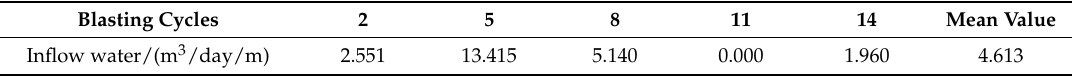
Table 4. Results of water inflow of upper section.